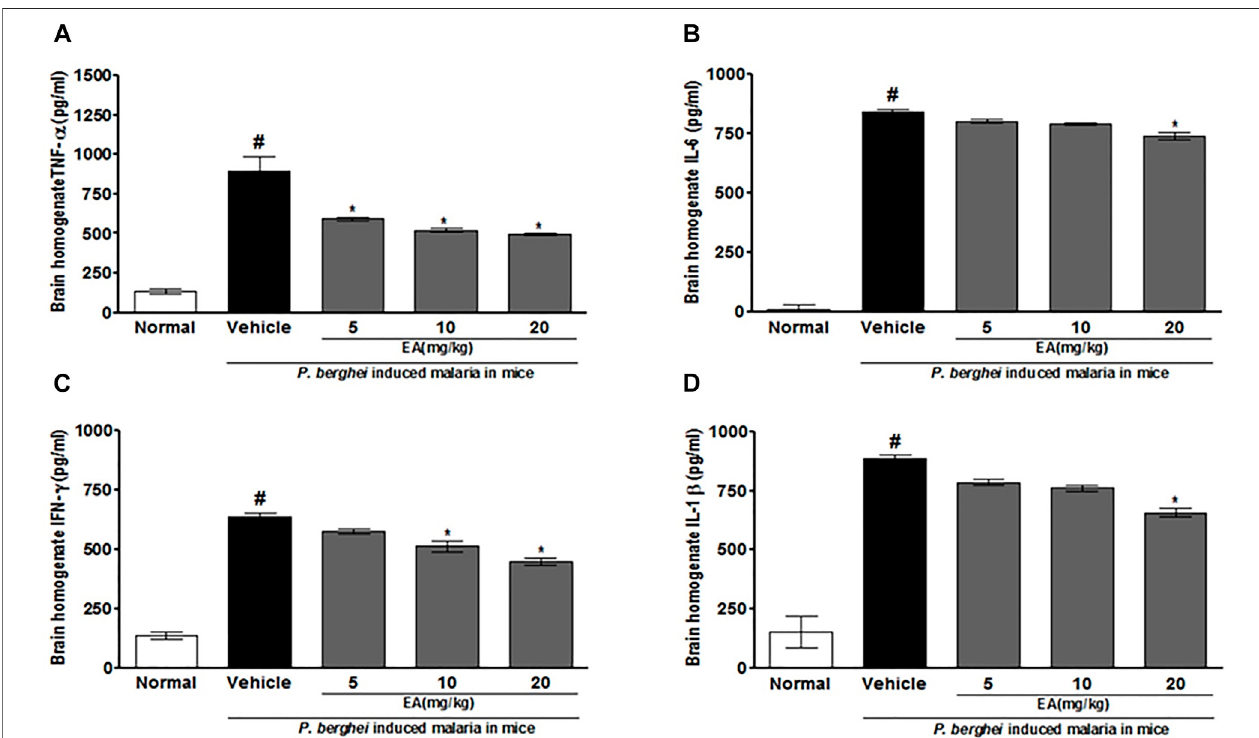
FIGURE 5 | Effect of EA on production of pro-in fl ammatory cytokines TNF- α , IL-6, IFN- λ and IL-1 β on peak day of parasitaemia in brain homogenate in P. berghei infected mice. Data are expressed as Mean ± SEM: P < 0.05; #Normal vs vehicle treated; *Vehicle vs treatment; n (cid:1) 3. #Normal vs vehicle treated; * p < 0.05; *Vehicle vs treatment; n (cid:1) 3.